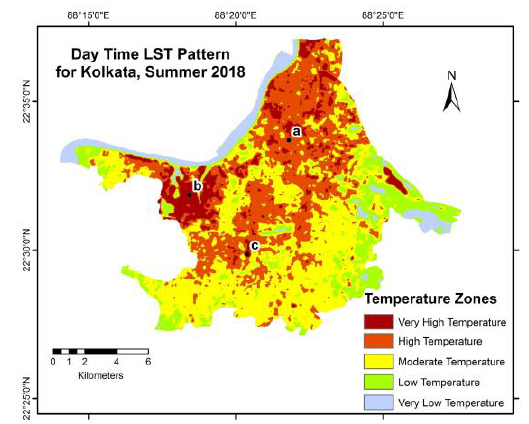
Figure 11. Day time LST and UHI of Kolkata in summer,